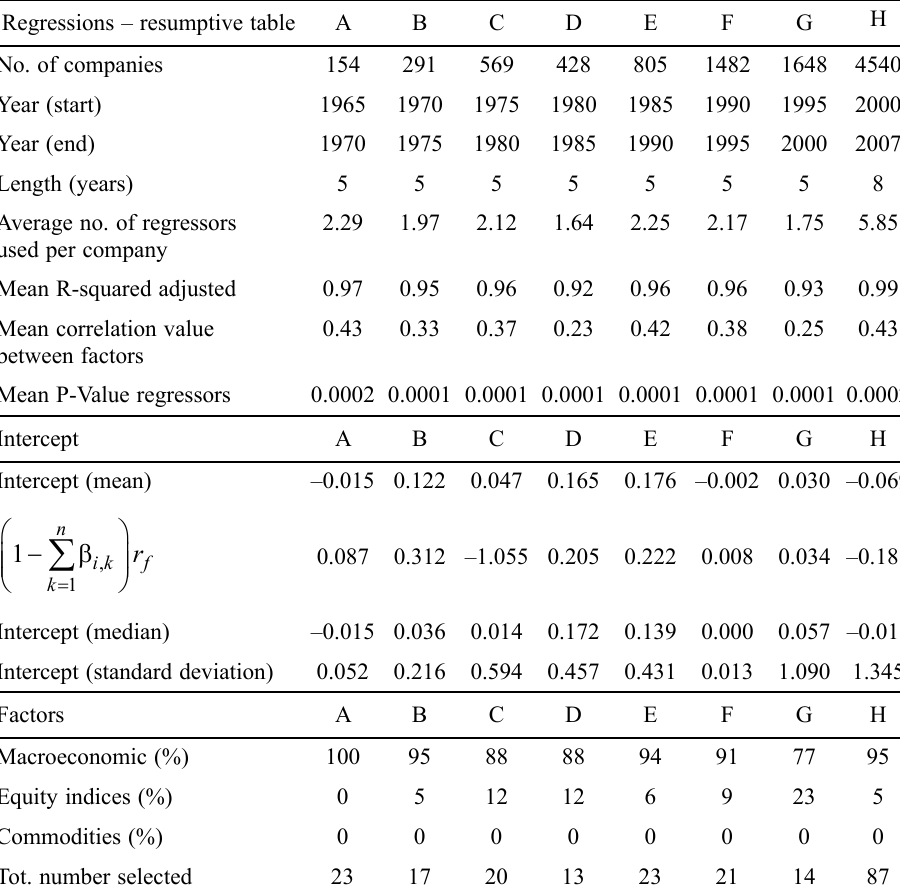
Table 2. Results of multiple regressions. Explanatory regressors per sub-periods analyzed Regressions – resumptive